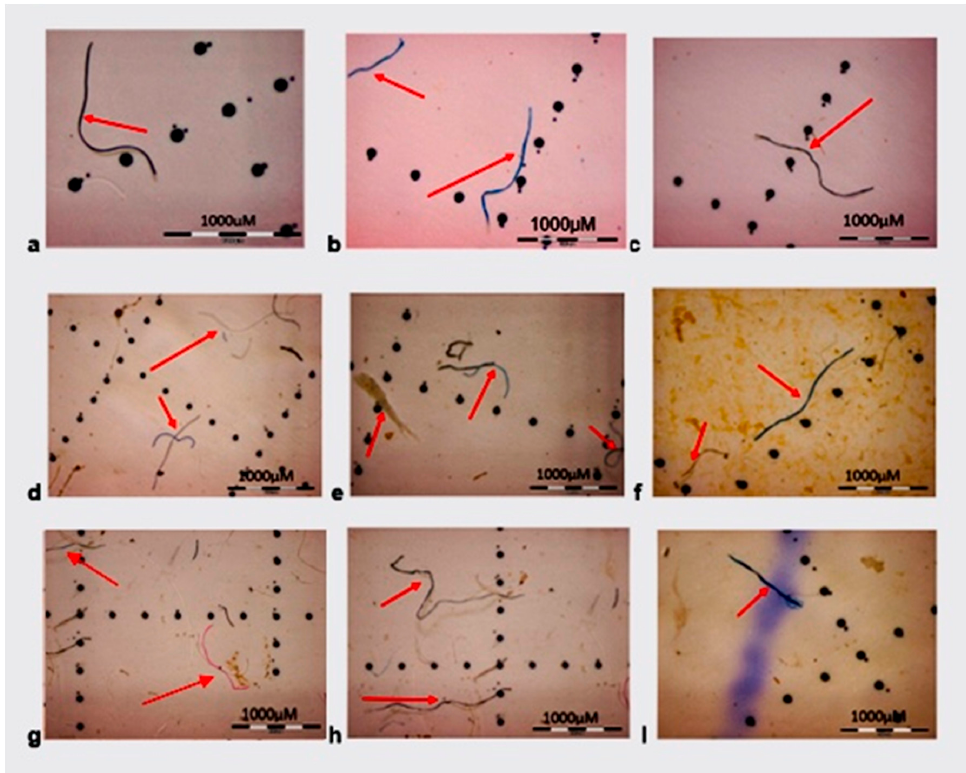
Figure 2. Stereo microscope images of microplastics filtered with PVDF membranes from ( a – c ) tap water, ( d , e ) lake water, ( f , g ) influent, and ( h , i )